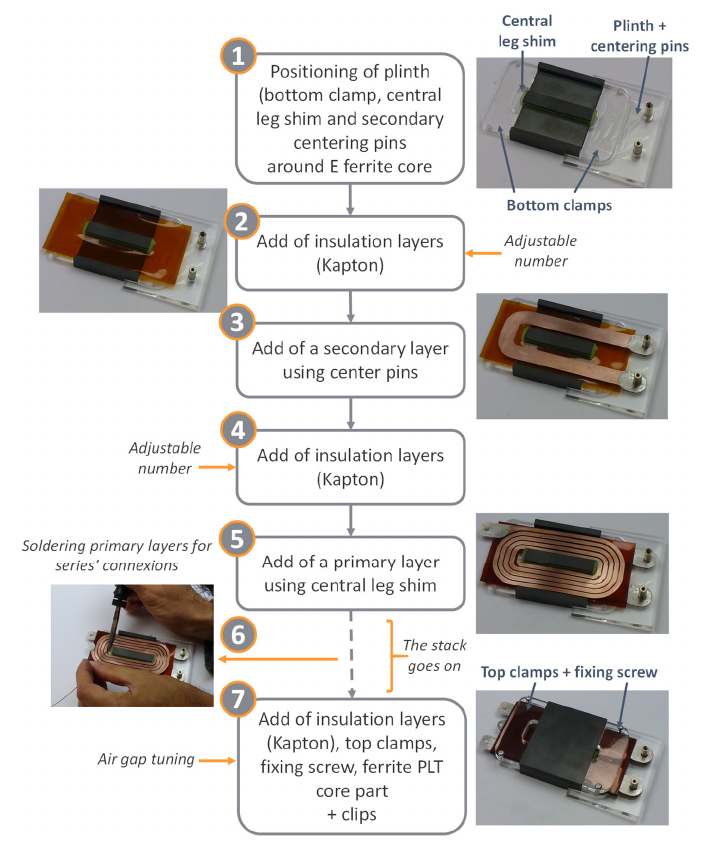
Figure 6. Assembling process layer by layer.